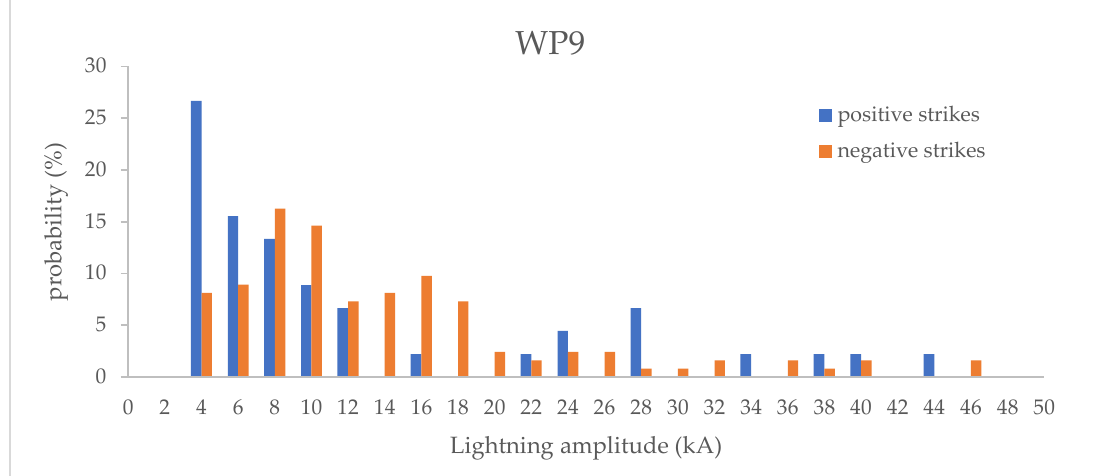
Figure A8. Lightning current amplitude probability distributions for positive and negative strikes extracted from the recorded incidents throughout the period 2011–2020 for WP8.